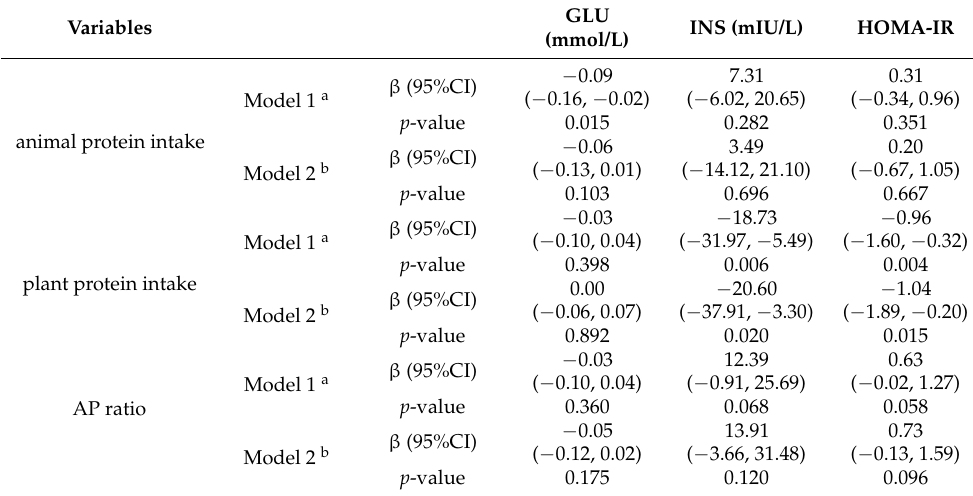
Table 4. The multiple linear regression results of animal protein intake, plant protein intake, AP ratio, and GLU, INS, or